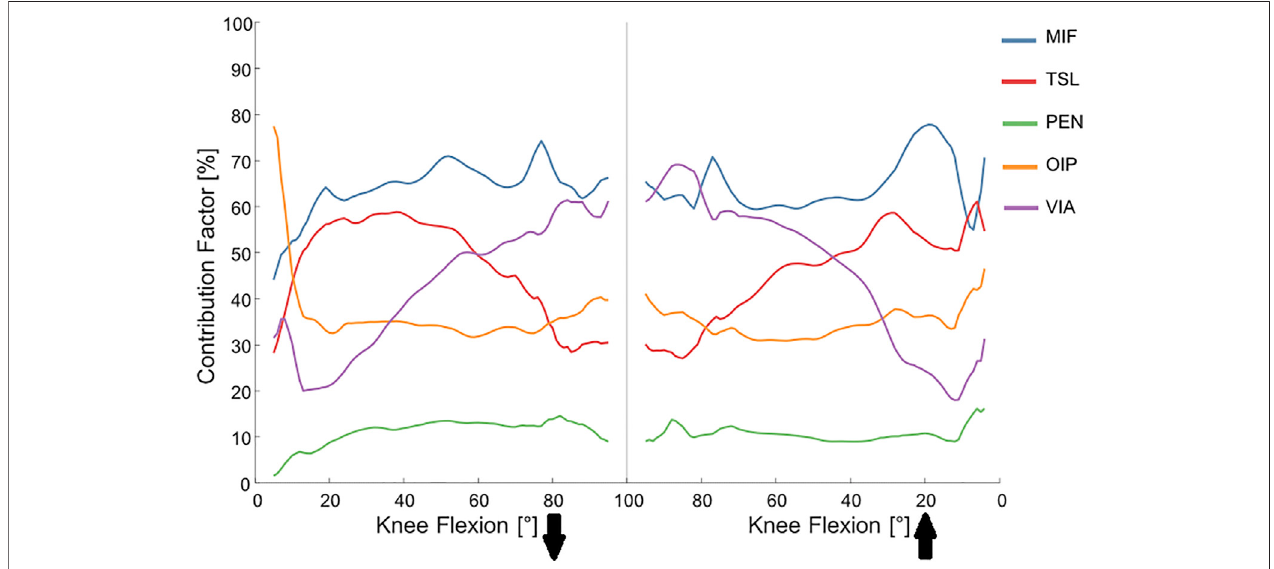
FIGURE 7 | Contribution of different muscle parameters toward the overall variability in KCF estimates. Solid lines represent average contribution factors obtained from the general and individual MCs with a total number of 24,000 JRF simulations (4,000 iterations per subject). MIF, maximum isometric force; TSL, tendon slack length; PEN, pennation angle; OIP, origin and insertion point; VIA, VIA points.